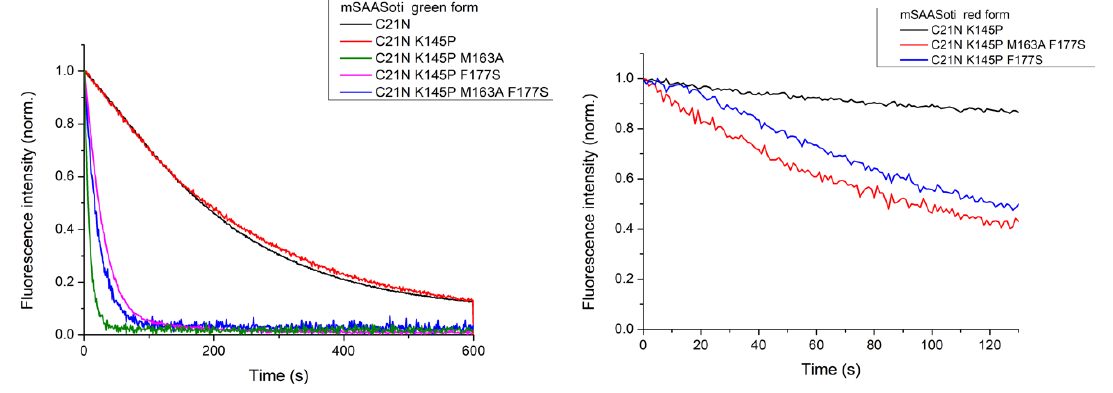
Figure 2. Photoswitching kinetics of the green ( left ) and red ( right ) mSAASoti mutant forms meas- ured during 470 nm and 550 nm illumination, respectively.